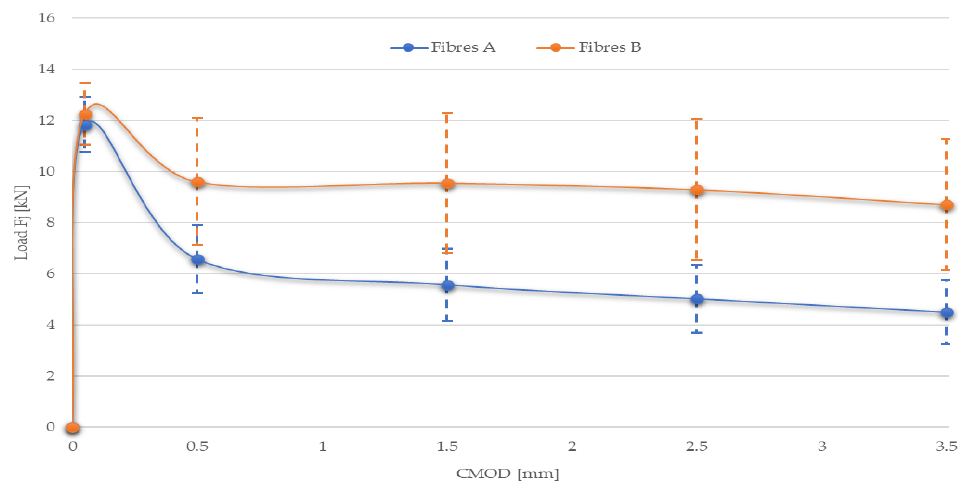
Figure 5. Load-CMOD diagram from concrete with fibres A and B.